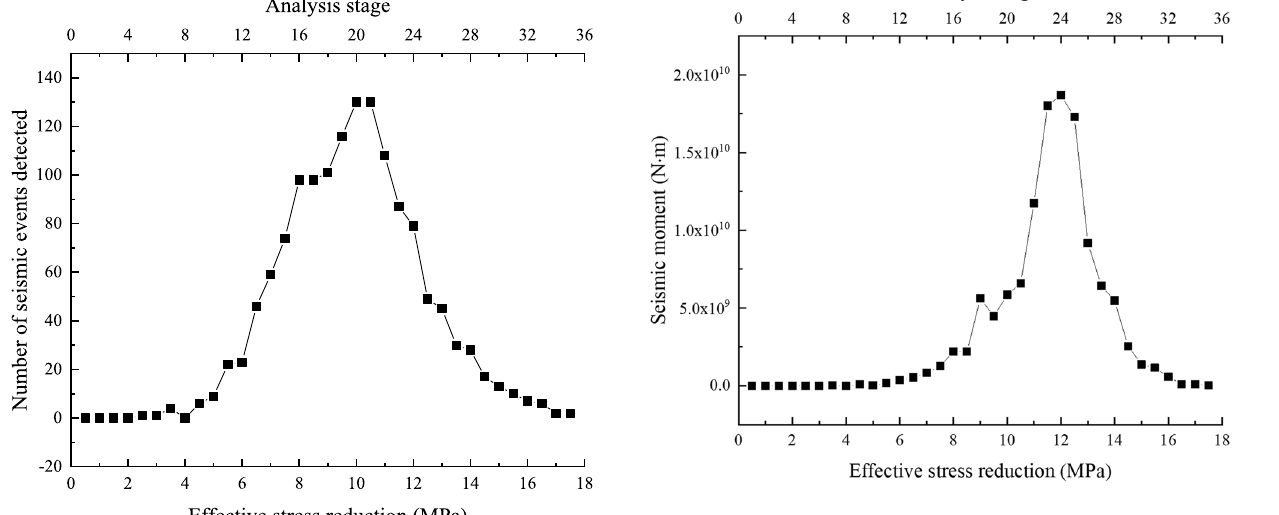
Fig. 11 Seismic moment increment at each analysis